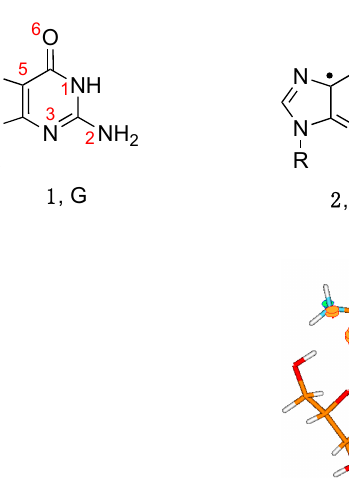
Figure 1. Structure 1 represents the guanine moiety in guanosine (Guo), 2 ′ -deoxyguanosine (dGuo), guanosine-5 ′ - monophosphate (GMP), 2 ′ -deoxyguanosine-5 ′ -monophosphate (dGMP), or 3 ′ ,5 ′ -cyclic guanosine monophosphate (cGMP); the atom numbering of the guanine moiety is given in red. The corresponding guanyl radicals G(N1-H) • ( 2 ) or G(N2-H) • ( 3 ); the part of the molecule involved in tautomerization is highlighted in red. SOMO of the two forms of guanyl radical G(N1-H) • ( A ) and G(N2-H) • ( B ) computed at the B3LYP/6-311G** level (taken from ref [11]).